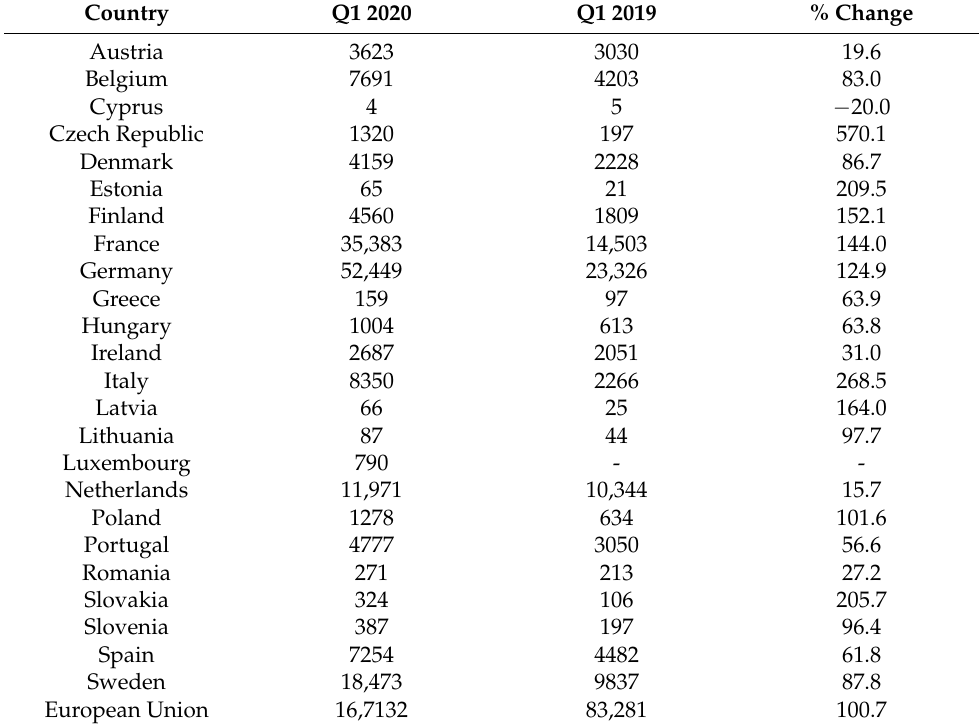
Table 5. Total number of electric and plug-in hybrid cars sold in Europe in the first